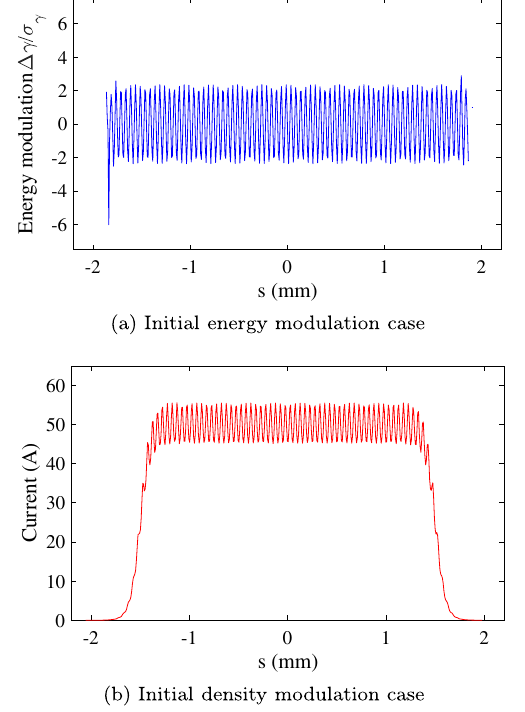
FIG. 3. The initial distributions: (a) the energy modulation amplitude for the case of the initial energy modulation, (b) the current profile for the case of the initial density modulation.